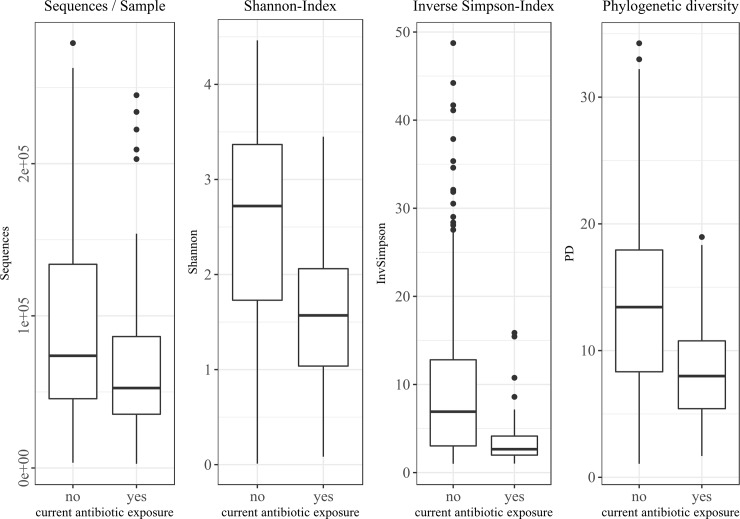
Effect of current antibiotic exposure on sequences per sample, Shannon-Index, inverse Simpson-Index and phylogenetic diversity (PD).No current antibiotic exposure: 310 samples; current antibiotic exposure: 95 samples.